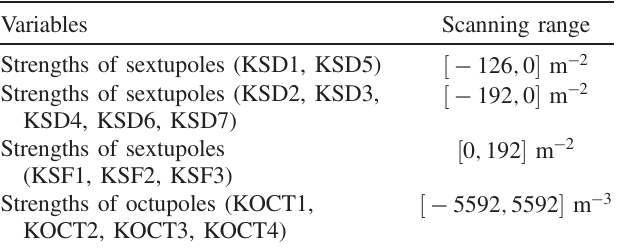
TABLE I. Variable ranges of the DA and TL